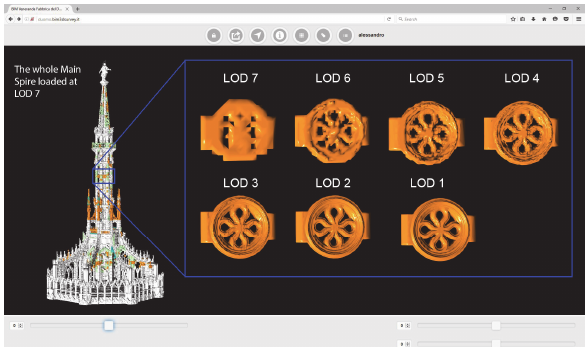
Figure 2. BIM3DSG web browser visualization of the same object at different